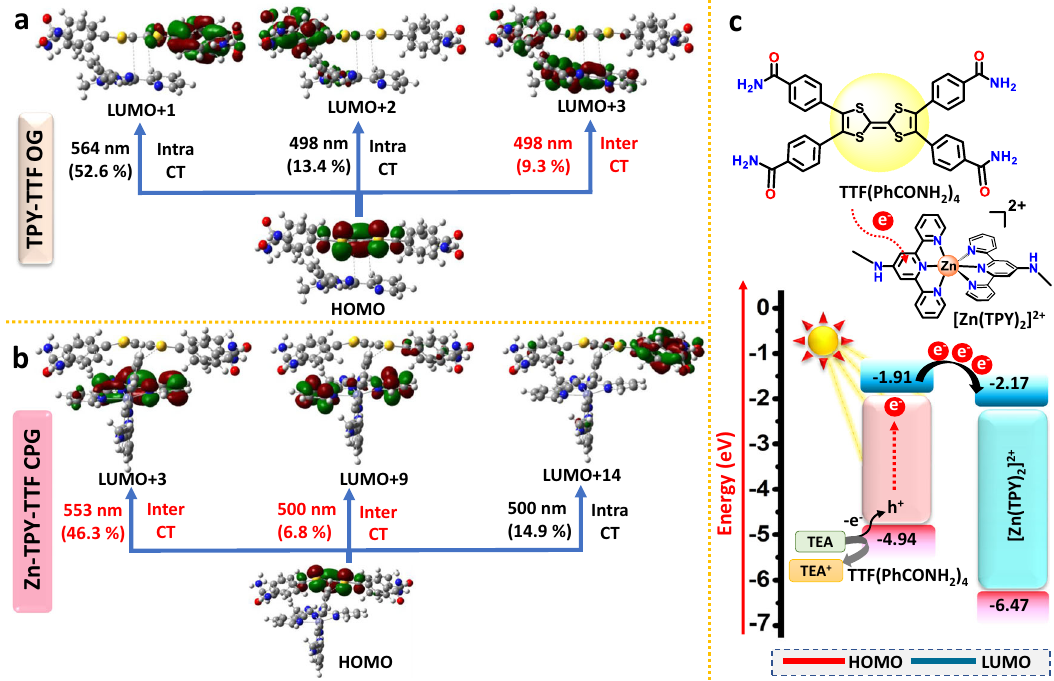
Fig. 4 DFT calculations for CT interaction and band alignments in TPY-TTF OG and Zn-TPY-TTF CPG. a , b HOMO-LUMO charge-transfer transitions with corresponding contributions from intramolecular and intermolecular charge transfer (CT) for TPY-TTF OG and Zn-TPY-TTF CPG, respectively. c HOMO-LUMO band alignments of TTF(PhCONH 2 ) 4 and [Zn(TPY) 2 ] 2 + for thermodynamic feasibility of electron transfer in the aqueous